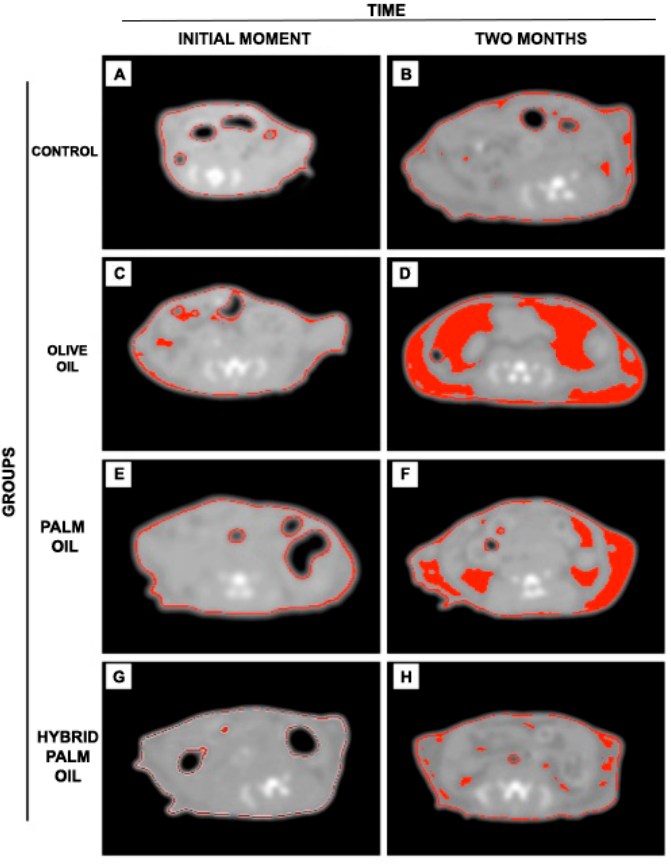
Figure 2. Axial tomographic slices between L4/L5 per dietary group, window levels (WL) -173 HU (Hounsfield units) to -109 HU. Segmentation of body fat (region in red) by ImageJ on the scale referring to adipose tissue of the animals. ( A ) control group (initial moment); ( B ) control group (2 months of diet); ( C ) olive oil group (initial moment); ( D ) olive oil group (2 months of diet); ( E ) palm oil group (initial moment); ( F ) palm oil group (2 months of diet); ( G ) hybrid palm oil group (initial moment); ( H ) hybrid palm oil group (2 months of diet).